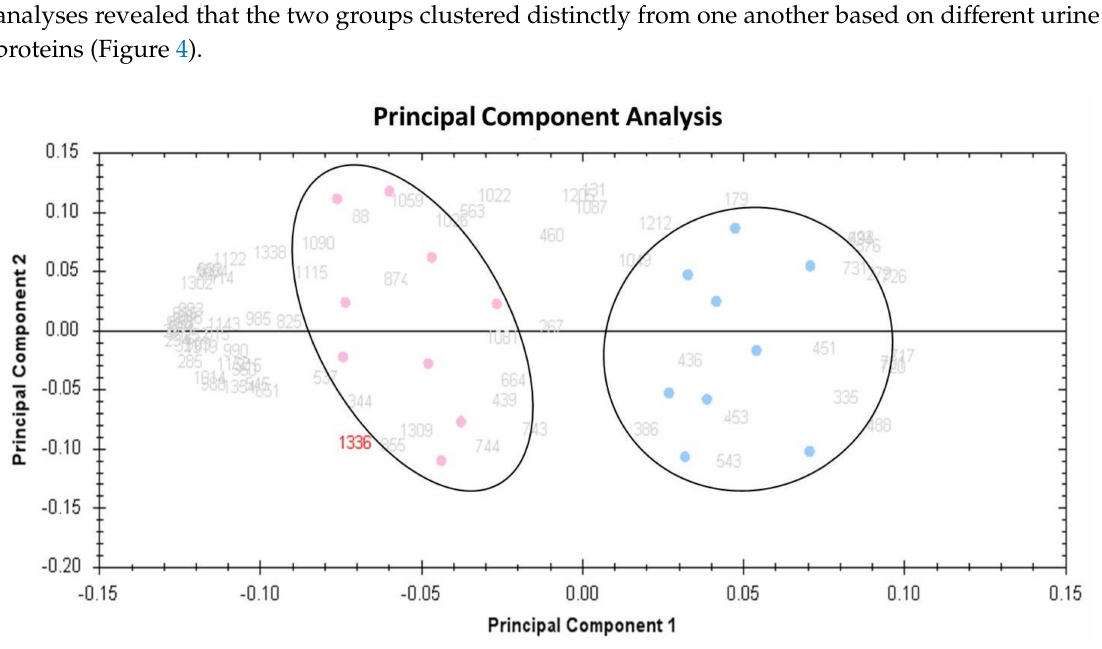
Figure 4. Principal component analysis (PCA) plot showing the two first principal components. Taken together, these explained 62 % of the selected spot’s variability values. Colored dots and numbers are the representation of gels and spots,